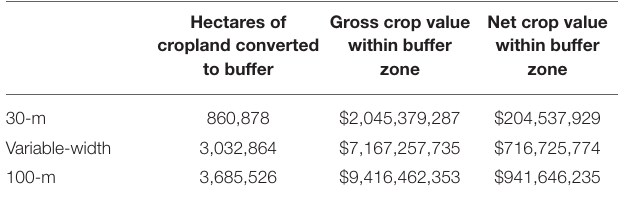
TABLE 8 | Estimated retention of sediment under different buffer scenarios and associated values of improved water quality.